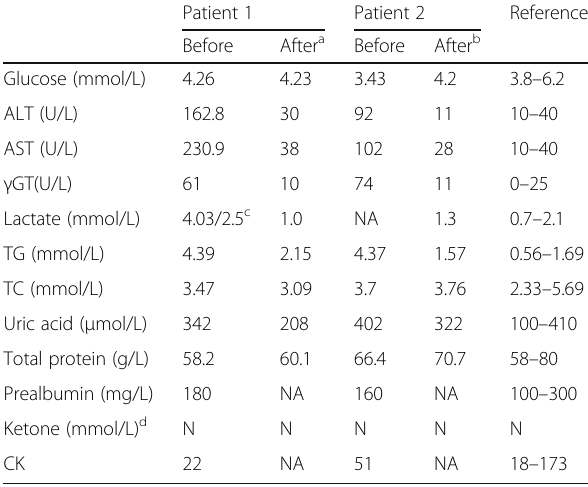
Table 1 Biochemical parameters of the two patients before and after treatment Patient 1 Patient 2